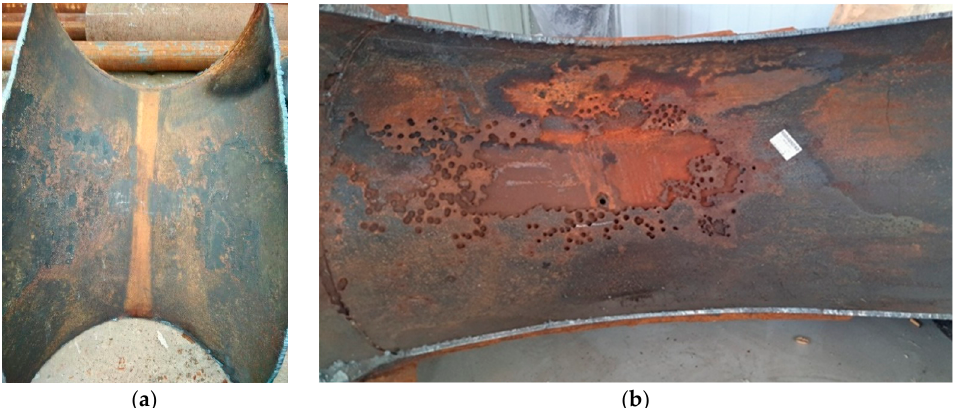
Figure 3. The corrosion profile of the elbow: ( a ) inside wall of the elbow; ( b ) outside wall of the elbow.